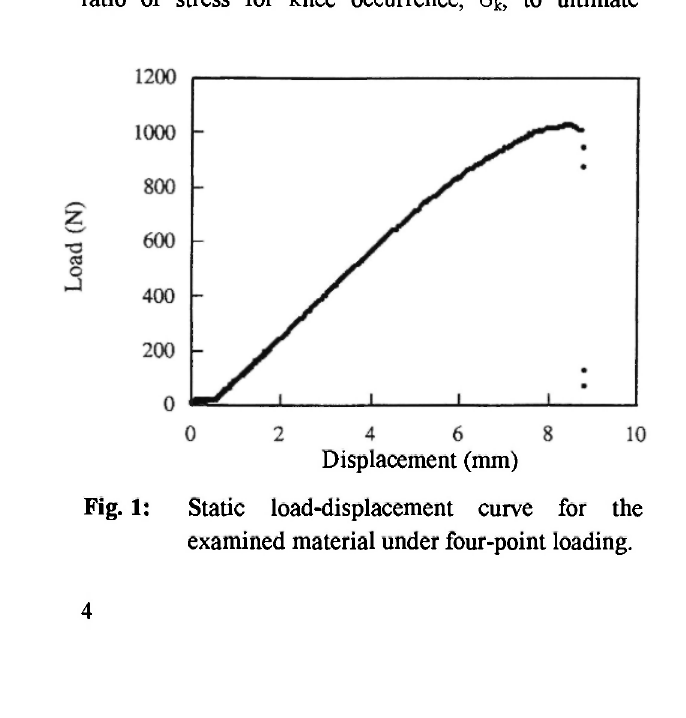
Fig. 1: Static load-displacement curve for the examined material under four-point